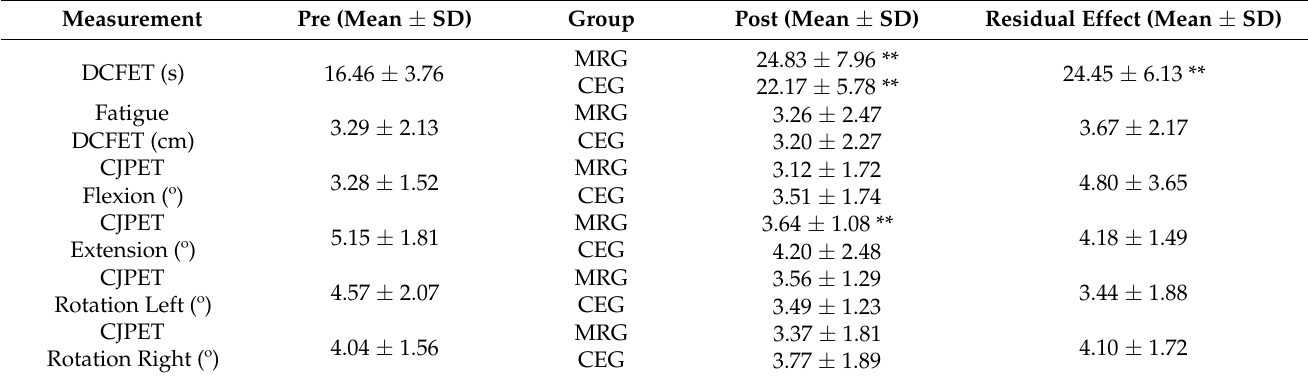
Table 1. Measurements comparing pre- and postintervention in both groups and residual